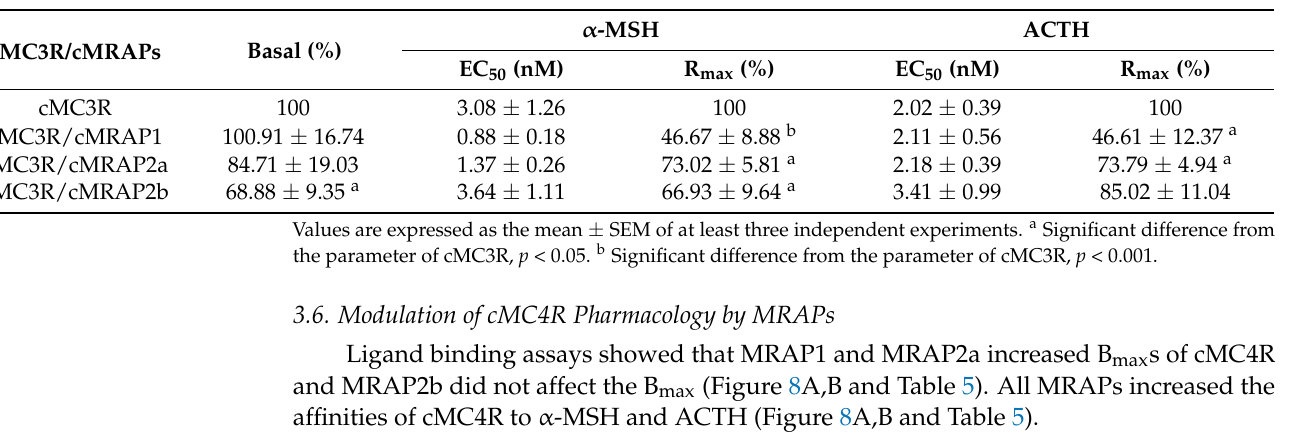
Table 4. The effect of MRAPs on cAMP signaling of cMC3R.